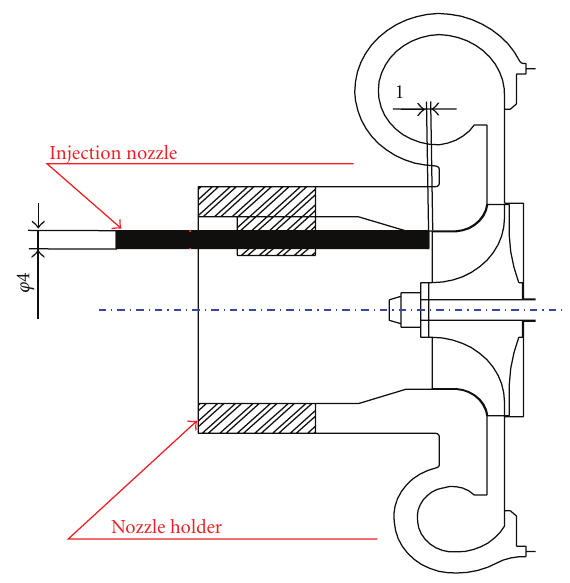
Figure 3: Injection nozzle (unit: mm).